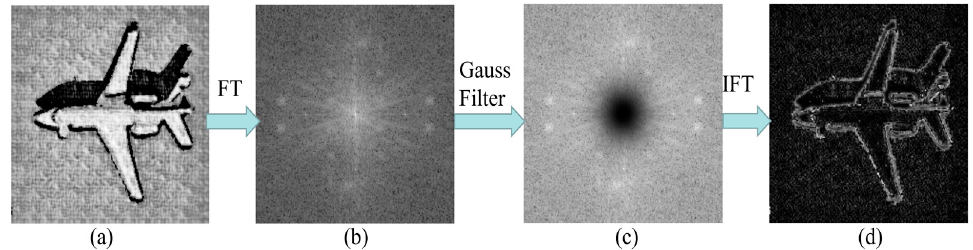
Figure 11. Frequency analysis on enhancement style transfer sample image. ( a ) Gray image on using style transfer directly. ( b ) Fourier transform on sonar image. ( c ) Gaussian filter frequency in frequency image. ( d ) Gaussian filtered image. Table 2. Three sonar styles applied on our style transfer process.